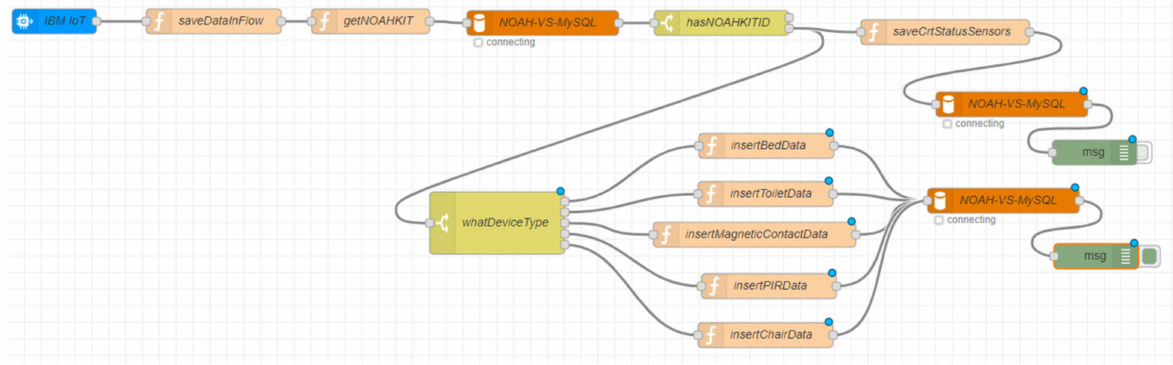
Figure 3. Collector flow in